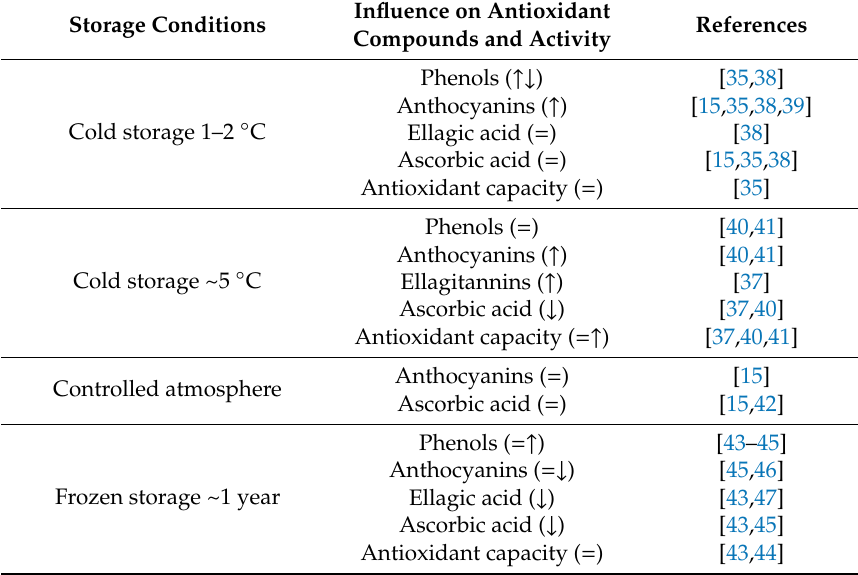
Table 1. Changes in content of some bioactive compounds and antioxidant capacity in fresh raspberry fruit by di ff erent raspberry storage conditions. ( ↑ ): increased contents; ( ↓ ): decreased contents; ( = ): unchanged